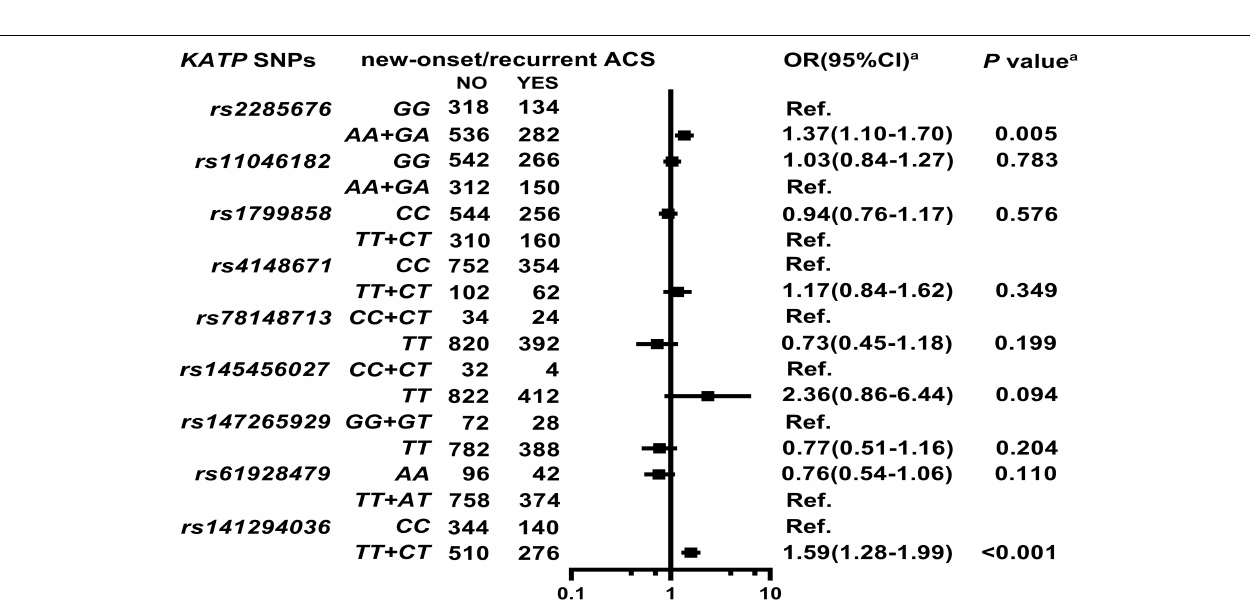
FIGURE 2 | Association of KATP SNPs with new onset/recurrent ACS in the study participants. a Model: After adjustment for gender, age, smoking, alcohol consumption, BMI, white blood cell count (WBC), blood glucose levels [fasting blood sugar (FBS), postprandial blood glucose 2 h (P2hBS) and glycosylated hemoglobin (HbA1C), liver function [alanine aminotransferase (ALT), aspartate aminotransferase (AST), and albumin (Alb)], renal function [serum creatinine (Scr), blood urea nitrogen (BUN) and uric acid (UA)], serum sodium and potassium levels, HsCRP, HbA1C, RAAS activity (ACE, renin, Ang I, Ang II, and ALD), dyslipidemia {triglyceride (TRIG), total cholesterol (TC), low-density lipoprotein cholesterol (LDL-C), apolipoproteinB (ApoB), high-density lipoprotein cholesterol (HDL-C), apolipoproteinA-I (ApoA-I), and lipoprotein(a) [Lp(a)]}, medical condition [type 2 diabetes (T2D), EH, heart failure (HF) and atrial fibrillation (AF)], NYHA functional classification, and echocardiography index [right ventricular end-diastolic diameter (RVD), right atrial end-diastolic dimension (RAD), left ventricular end-diastolic diameter (LVD), left atrial end-diastolic dimension (LAD), left ventricular mass index (LVMI), and left ventricular ejection fraction (LVEF)], and combined medication [antiplatelet drugs, warfarin, statins, renin-angiotensin system inhibitors (RSIs), beta-receptor blockers (BBs), mineralocorticoid receptor antagonist (MRA), calcium-channel blockers (CCBs), diuretics, digoxin, nitrates, and hypoglycemic agents].